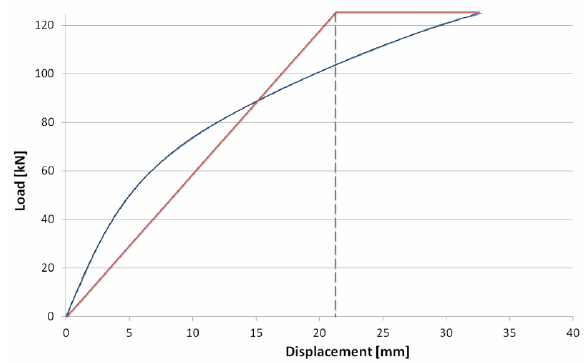
Figure 14. Determination of the idealized elasto- perfectly plastic force-displacement relationship for the frame with flexible